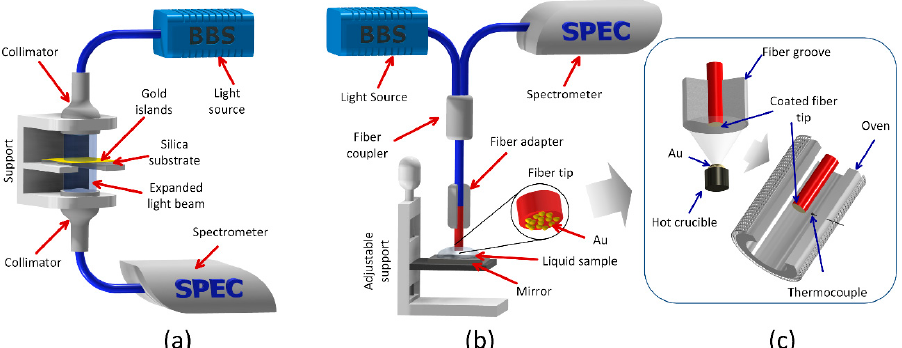
Figure 1. ( a ) Setup for the measurement of the absorption spectra in transmission mode of planar silica samples coated with gold nano-islands, ( b ) Setup for measurement in reflection mode of refractive index sensitivity of optical fibers coated with gold nano-islands, ( c ) Set-up for coating with Au only the end surface of the fibers; after Au coating, annealing took place in an